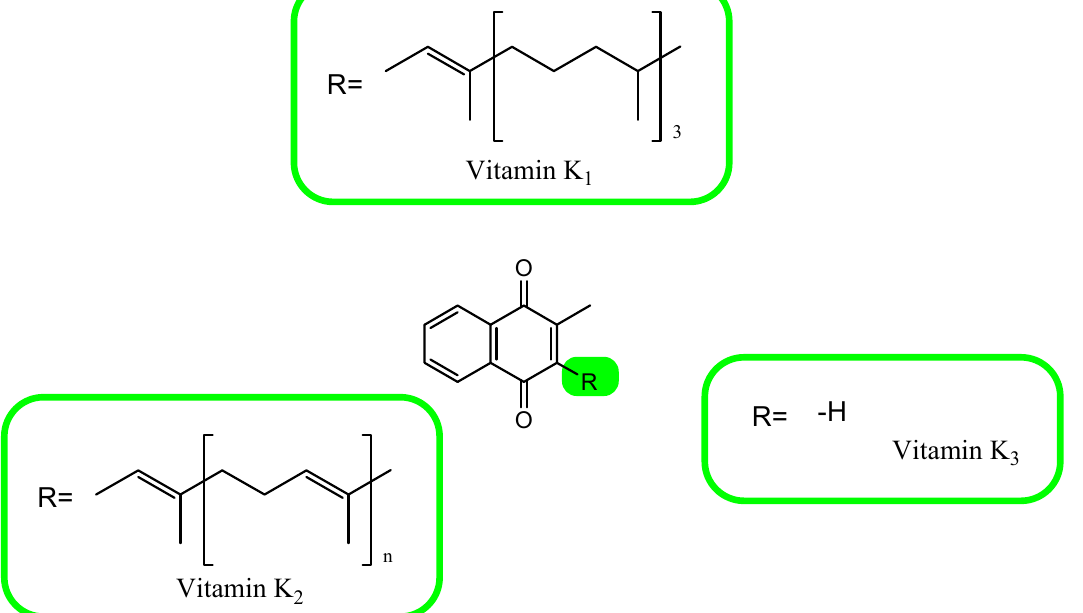
Figure 3. The chemical formula of vitamin K.